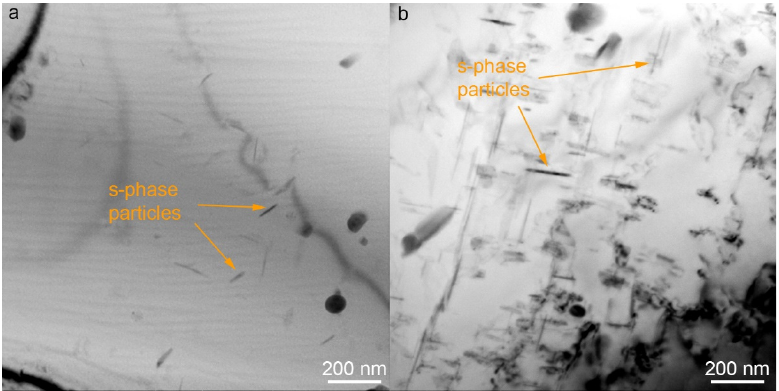
Figure 10. Bright ‐ field TEM images of the UAFSW joint stir zone at the boundary ( a ) and in the Figure 10. Bright-field TEM images of the UAFSW joint stir zone at the boundary ( a ) and in the center center of the transfer layer ( b ). of the transfer layer ( b